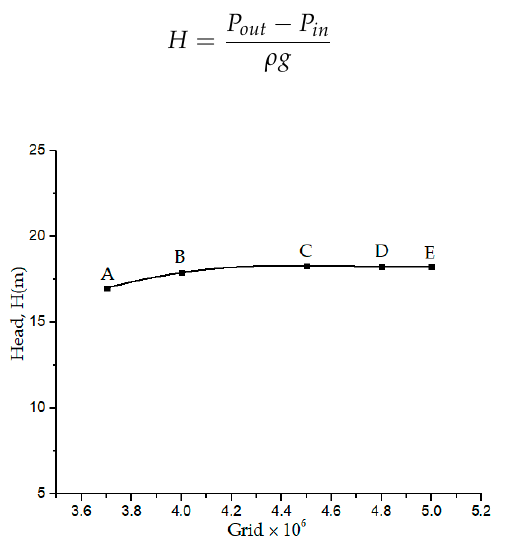
Figure 2. Mesh independence analysis.